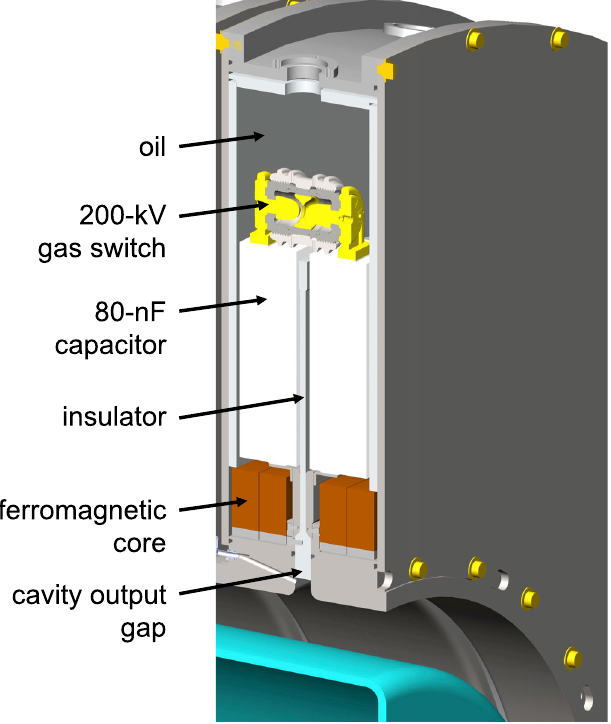
FIG. 3. Cross-sectional view of a single 2-m-diameter Z-300 LTD cavity. The upper terminal of one of the two capacitors is charged to þ 100 kV; the upper terminal of the other is charged to − 100 kV. The lower terminal of each capacitor is initially at ground potential. When the capacitors are fully charged, the potential difference across the switch is 200 kV. After the switch closes, the peak voltage across the cavity ’ s output gap reaches ∼ 100 kV. The ferromagnetic cores prevent most of the LTD ’ s current from flowing along the inner walls of the cavity, which allows most of the current to be delivered to the output